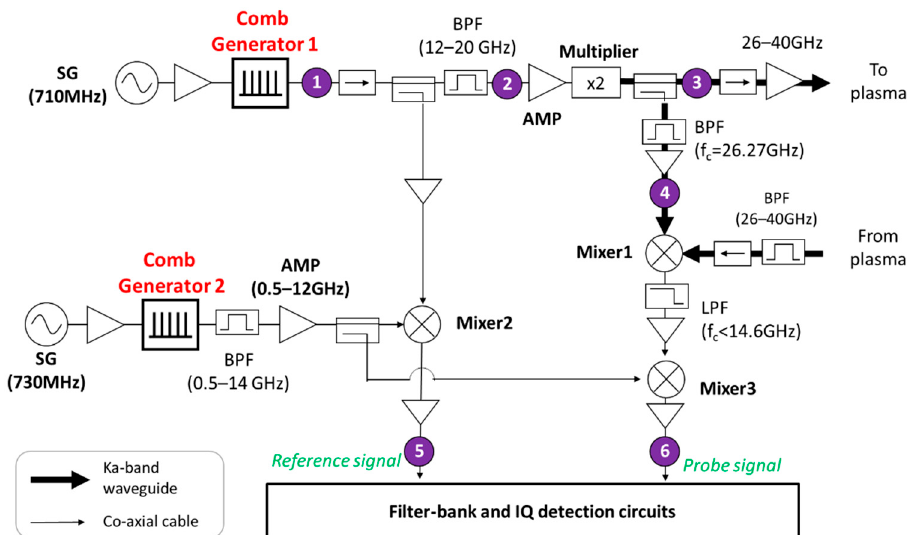
Figure 6. Schematic diagram of Ka-band dual-comb Doppler reflectometer system. Here, SG is signal generator used as clock for comb generation, AMP is amplifier, BPF is band-pass filter, and LPF is low-pass filter. Numbers 1, 2, 3, 4, 5, 6 in figure indicate monitoring points in following figures.